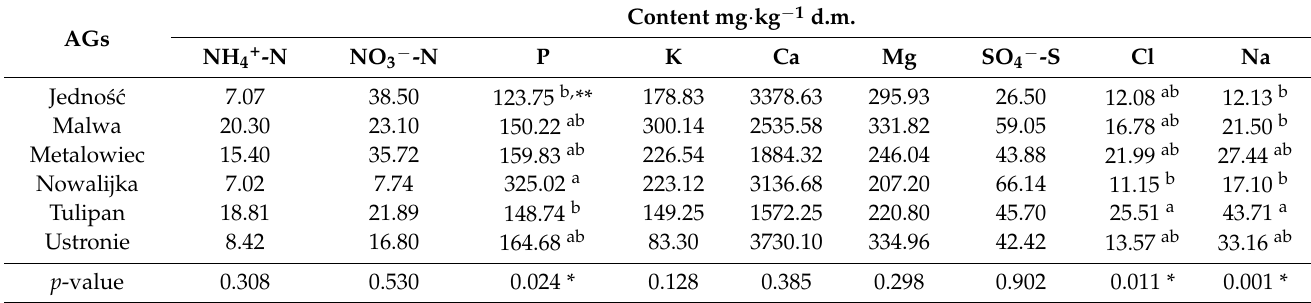
Content mg · kg − 1 d.m.